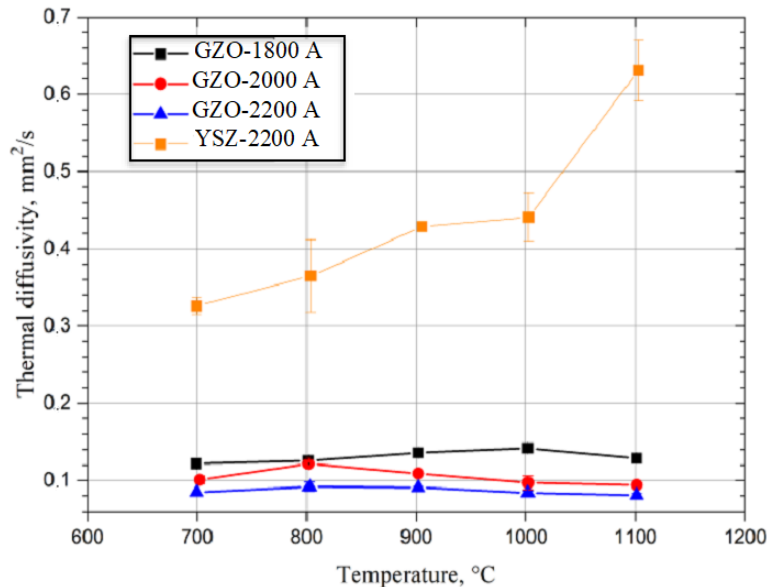
Figure 5. Measured diffusivity for YSZ and for Gd 2 Zr 2 O 7 (GZO-1800A, -2000A, and -2200A) layers produced using different power current values.